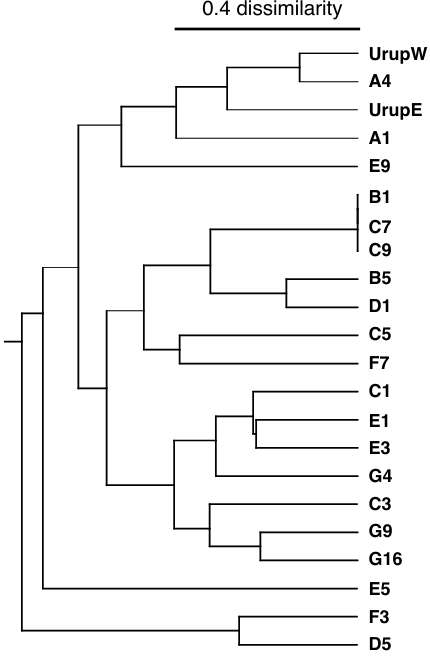
Fig. 4. Cluster dendrogram of the diatom species richness at each sampling station.